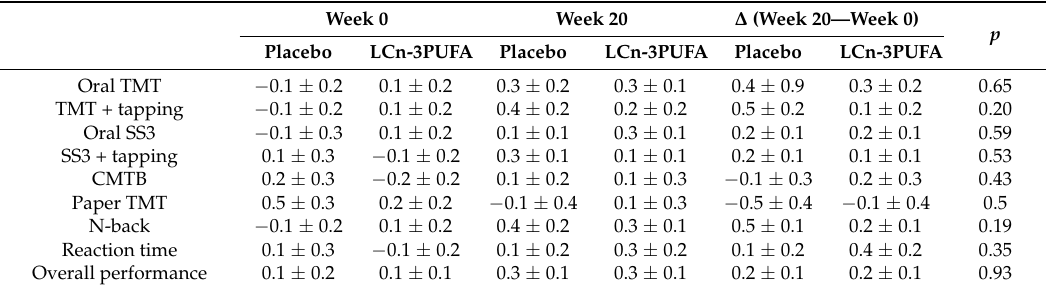
Table 3. Z-scores for the cognitive test battery and overall cognitive performance at baseline and end of intervention in placebo and LCn-3PUFA groups; treatment differences are also